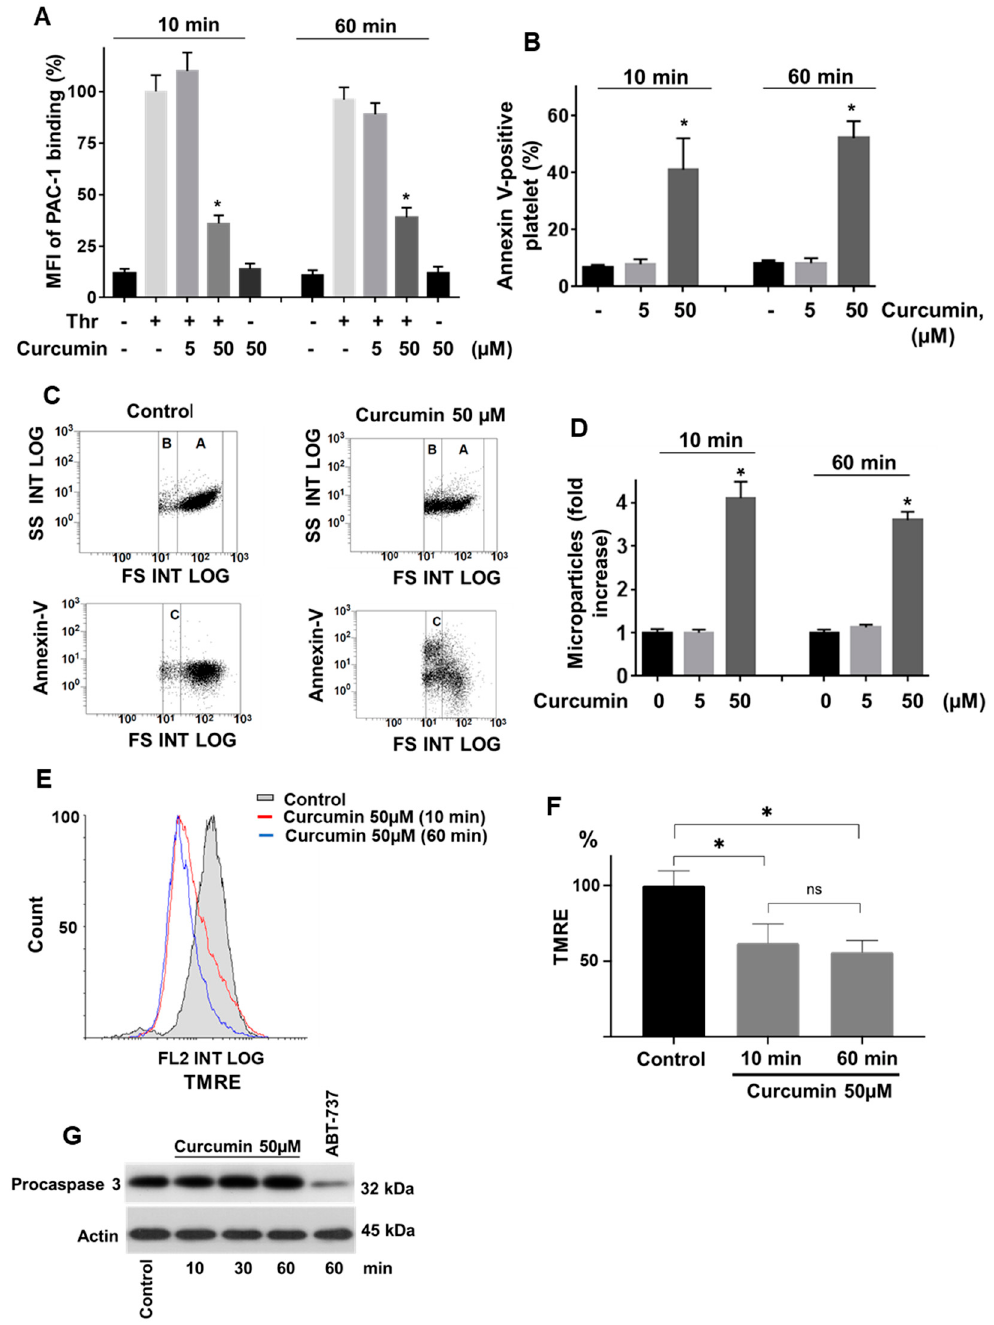
Figure 1. Curcumin inhibits thrombin-induced platelet α IIb β 3 integrin activation and does not stimulate caspase 3-dependent apoptosis. ( A ) Flow cytometric analysis of α IIb β 3 integrin activation (PAC-1-FITC binding), ( B ) PS surface exposure (annexin-V-PE binding), ( C , D ) microparticle formation, ( E , F ) mitochondrial membrane potential changes (TMRE fluorescence), and ( G ) Western blot of caspase 3 activation. Washed platelets (WP 1 × 10 8 /mL in A-F and 3 × 10 8 /mL in G) were incubated with the indicated concentrations of curcumin for 10 and 60 min. ( A ) Thrombin (0.01 U/mL) was added for 2 min, followed by PAC-1-FITC antibody (1:10 dilution) for 10 min, and the reaction was stopped by dilution (10 volumes) with PBS. ( B ) WP were incubated with the indicated concentrations/time of curcumin, then annexin-V-PE (dilution 1:10) was added for an additional 10 min, and the reaction was stopped by dilution (10 volumes) with annexin-V-binding solution. ( C ) Representative (from four independent experiments) dot plot of microparticle formation (upper panel), and annexin-V-PE positive platelets and microparticles (lower panel). Annexin-V-PE was analyzed as shown in B. ( D ) Quantification of platelet microparticle formation. Microparticles were quantified as CD42a positive events in the gate